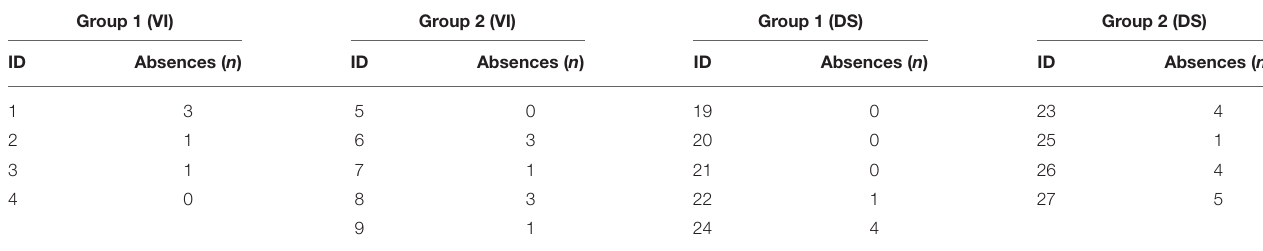
TABLE 4 | Assigned groups and number of absences (out of 20 intervention sessions). Group 1